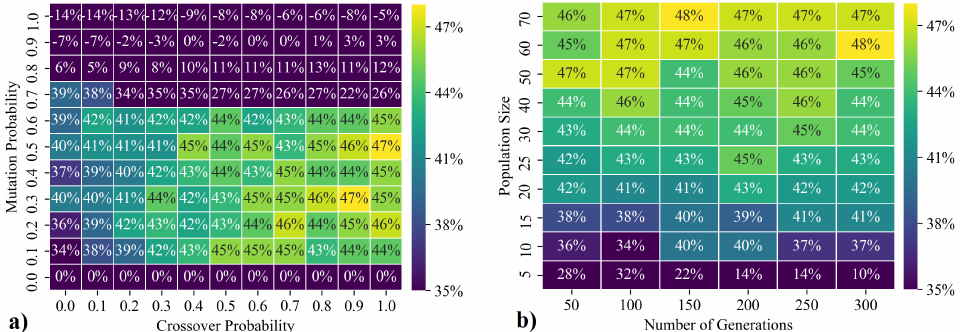
Figure 4. Parameter variation genetic algorithm with constrains. ( a ): Number of generations and population size set to 50; ( b ): Crossover probability set to p c = 0.9 and mutation probability set to p m =